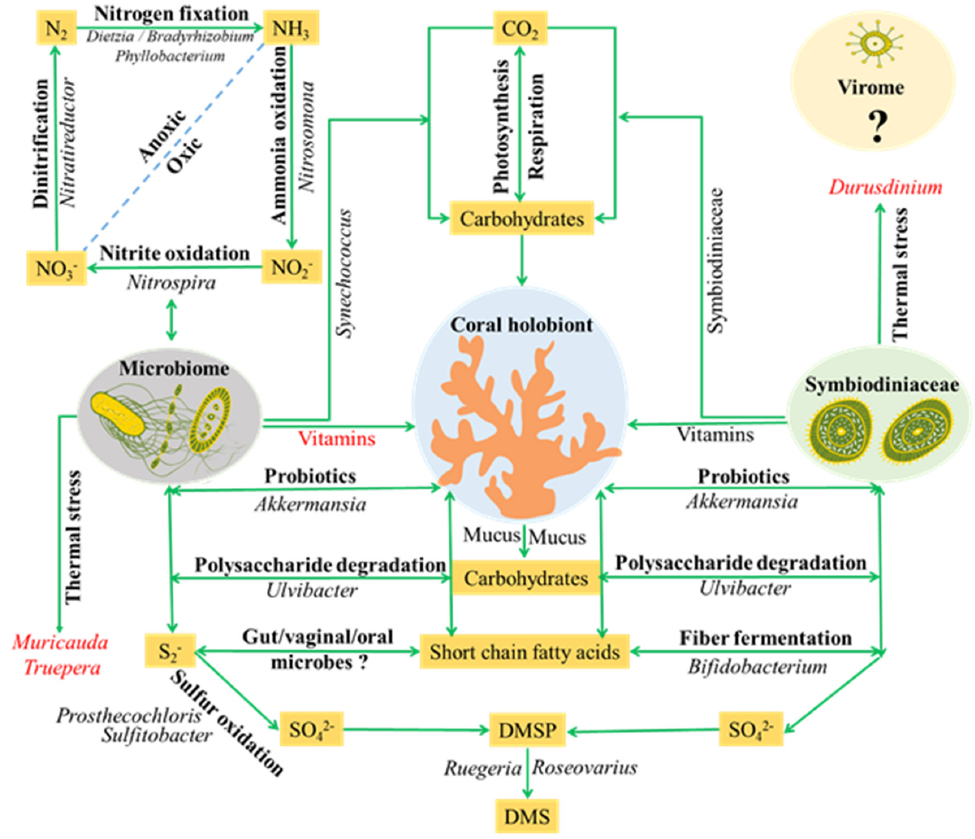
Figure 6. A schematic representation illustrating potential roles and relationships among coral, micriobiome and Symbiodianecean. Potential roles might be played in host nutrients metabolism (carbon, nitrogen and sulfur cycles) and thermal stress. The bacteria genus denoted in italics were mapped onto the well-known ecological processes. The gut / vaginal / oral microbes and Virome are likely to be important targets in future studies. The question mark (?) means that the roles of microorganisms in coral holobiont are unknow at present. The blue dot line represents two kinds of notrogen cycles (Oxic and Anoxic).